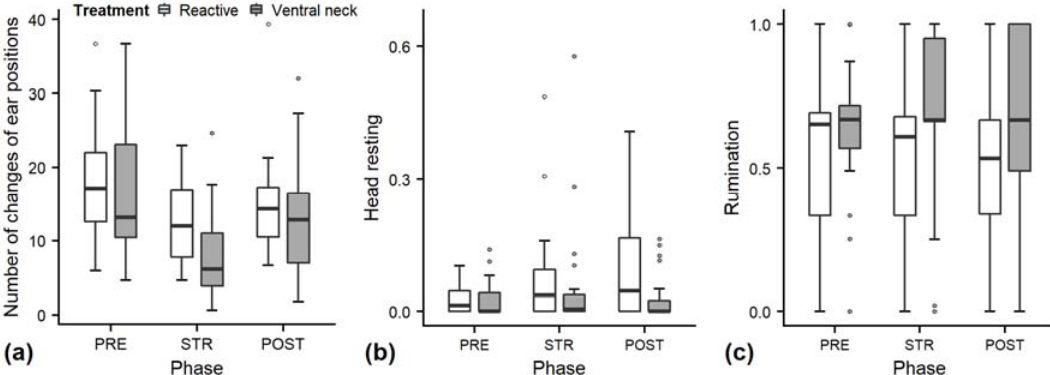
Figure 4. Means of changes of ear position ( a ), head resting ( b ) and rumination ( c ) of heifers ( n = 28). ( a ): number of changes of ear positions; ( b , c ): durations of behaviour as a proportion of the total time observed. Means were calculated across the three trials per treatment and are depicted according to the treatment used (white = “reactive”, dark grey = “ventral neck”) and phase (PRE = pre-stroking, STR = stroking, POST = post-stroking). Note that the y-axis scale varies to allow for su ffi cient resolution for rare behaviours.